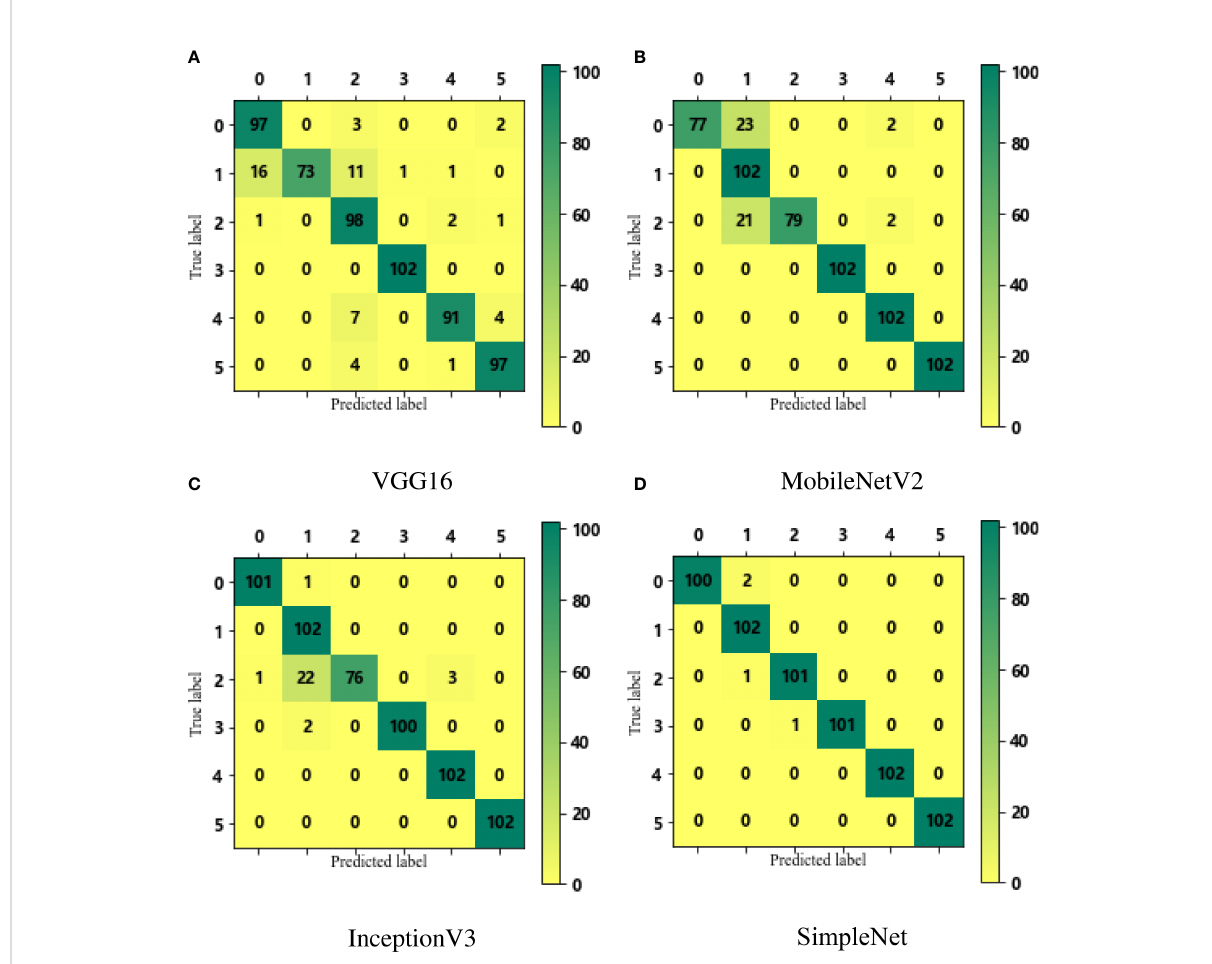
FIGURE 8 The confusion matrices for VGG16, MobileNetV2, Inception V3 and SimpleNet to identify six rice leaf diseases (as shown in sub- fi gure A – D